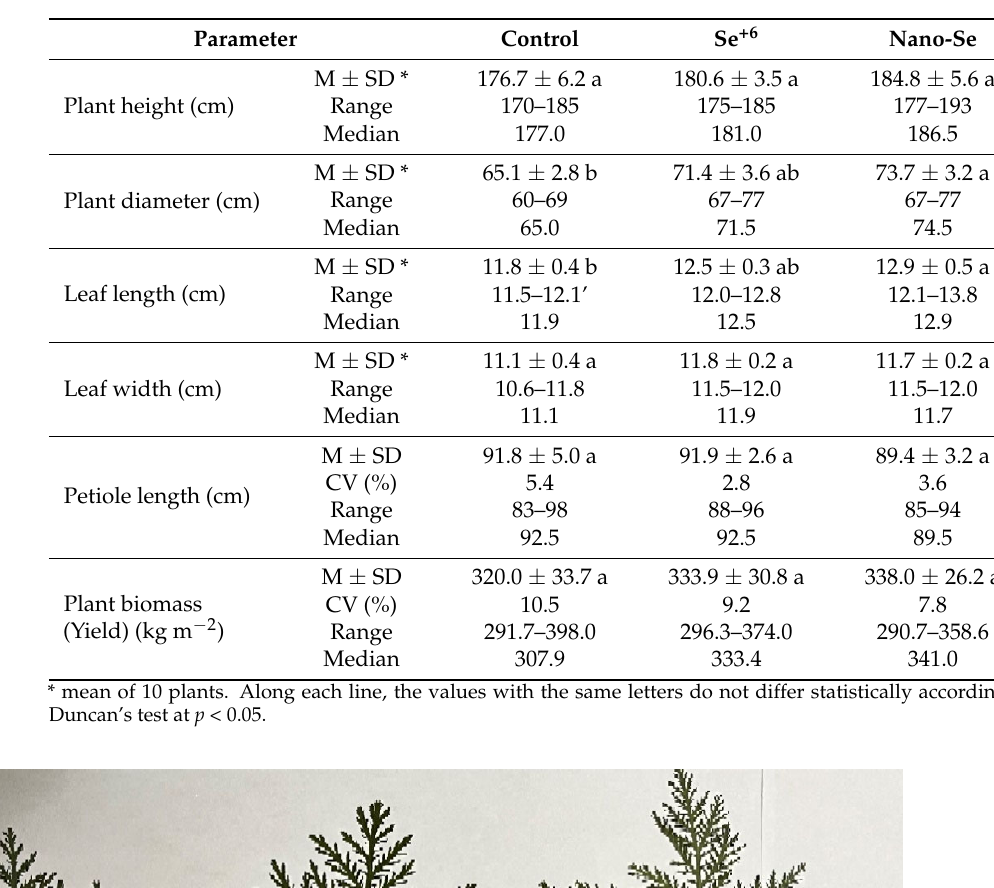
Table 1. Morphological characteristics of A. annua .